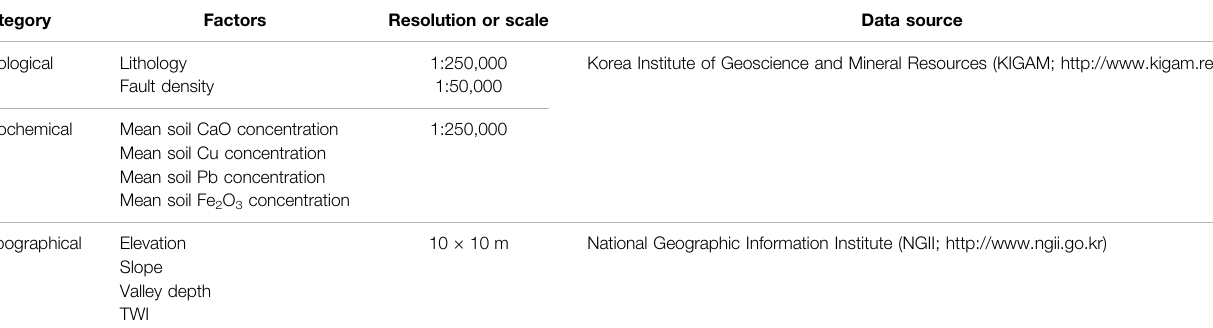
TABLE 1 | Factors considered to map indoor radon